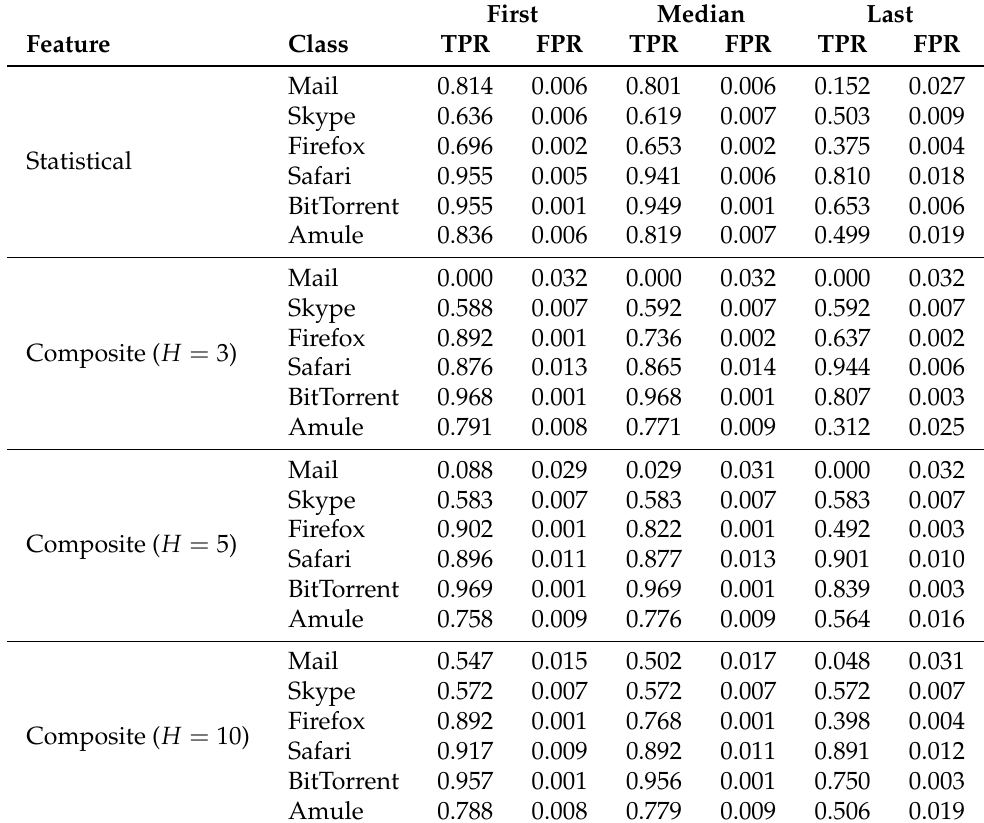
Table 15. Proposed method: Performance over UniBS data